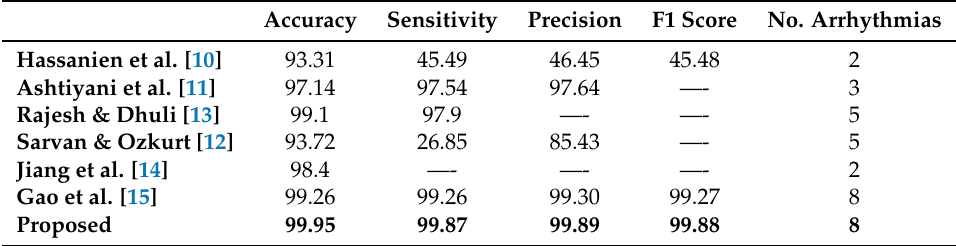
Table 14. Comparison of the method proposed with the state of the